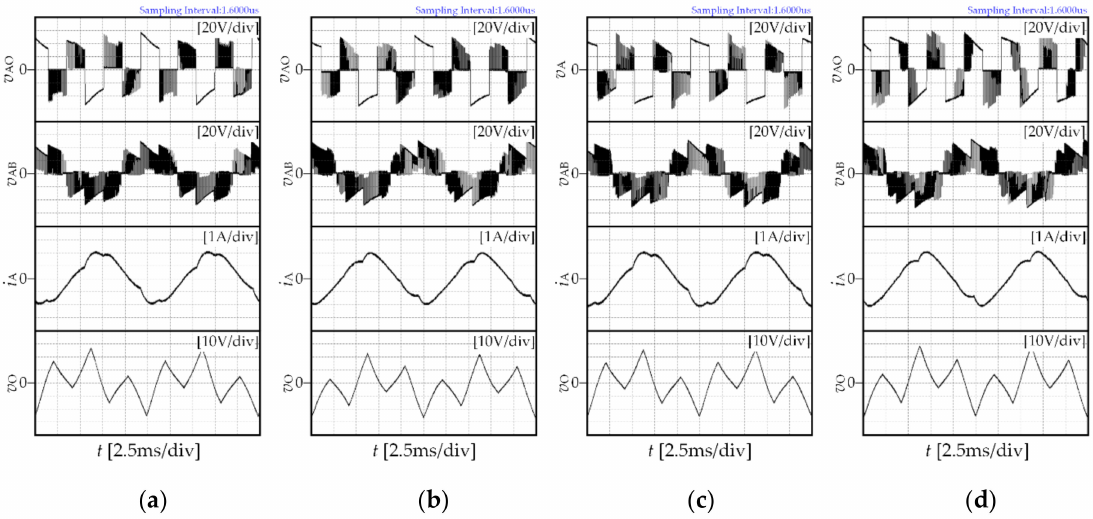
Figure 7. Experimental results of DPWM0–DPWM3 under two-phase load conditions when m’ = 0.3: